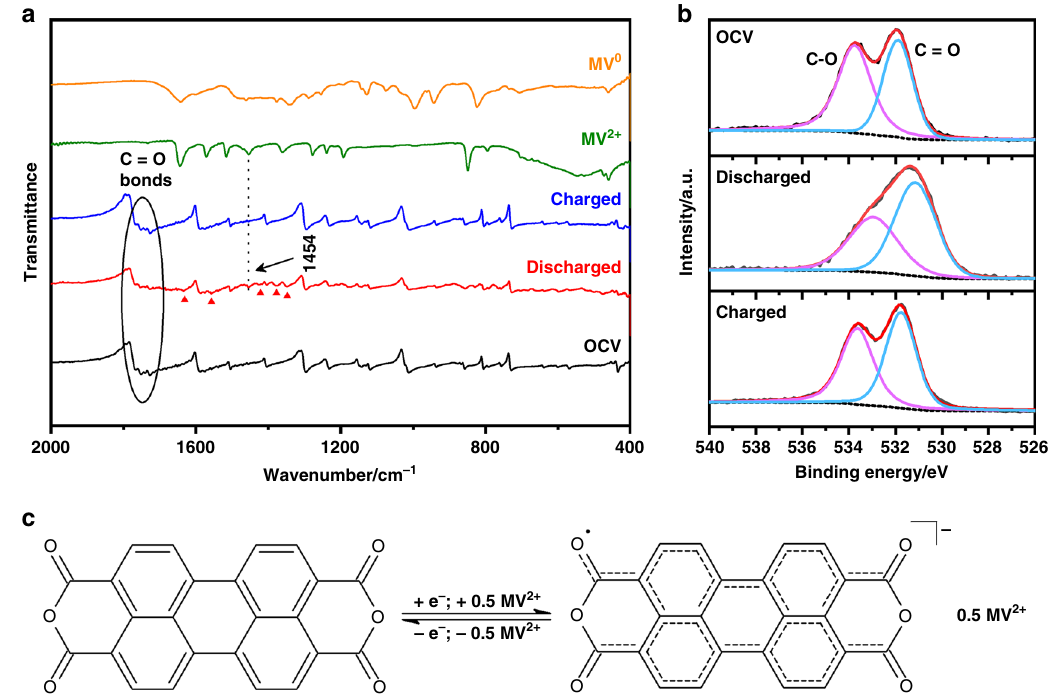
Fig. 4 Analysis of the reaction mechanism during the electrochemical process. a FTIR spectra of the PTCDA electrode recorded at different SOC: OCV (black), the initial discharged (red), the charged state (blue), and FTIR spectra of methyl viologen dichloride powder (green) and its reduced form of MV 0 (orange); b XPS O 1s spectrum of PTCDA electrodes recorded at different SOC; c Schematic illustration showing the possible reversible